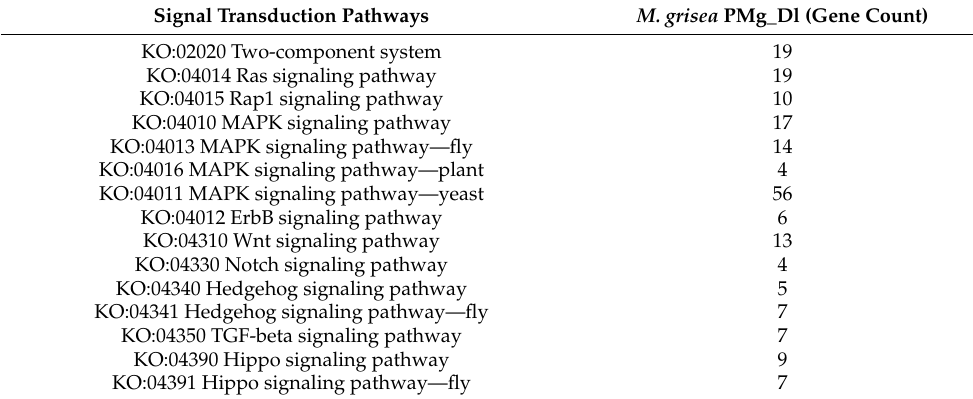
Table 5. Signal transduction KEGG (Kyoto Encyclopedia of Genes and Genomes) pathways for M. grisea PMg_Dl. Signal Transduction